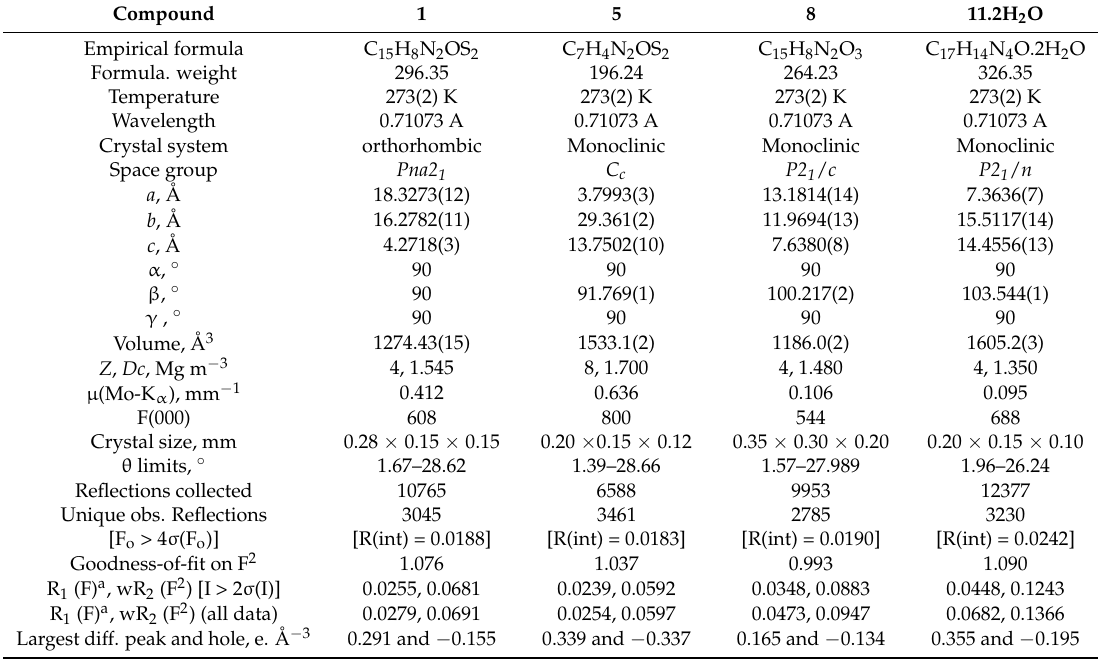
Table 3. Crystal data and structure-refinement details for 1 , 5 , 8 , and 11.2H 2 O